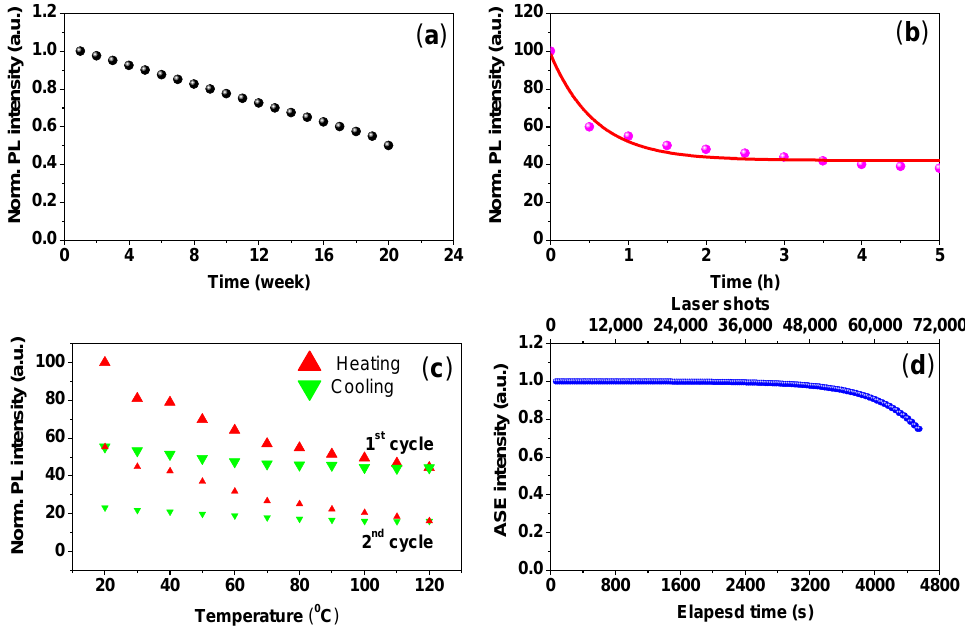
Figure 7. ( a ) PL intensity versus immersion time in water; ( b ) time-dependent PL intensity under UV lamp excitation; ( c ) temperature-dependent PL intensity of the composite in both stage heated and cooled; ( d ) shot-dependent ASE intensity of the CsPbBr 3 /PMMA thin disk.